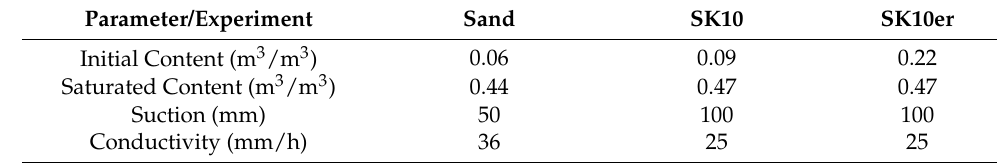
Table 2. Green and Ampt initial parameters that were used for the rainfall–runoff